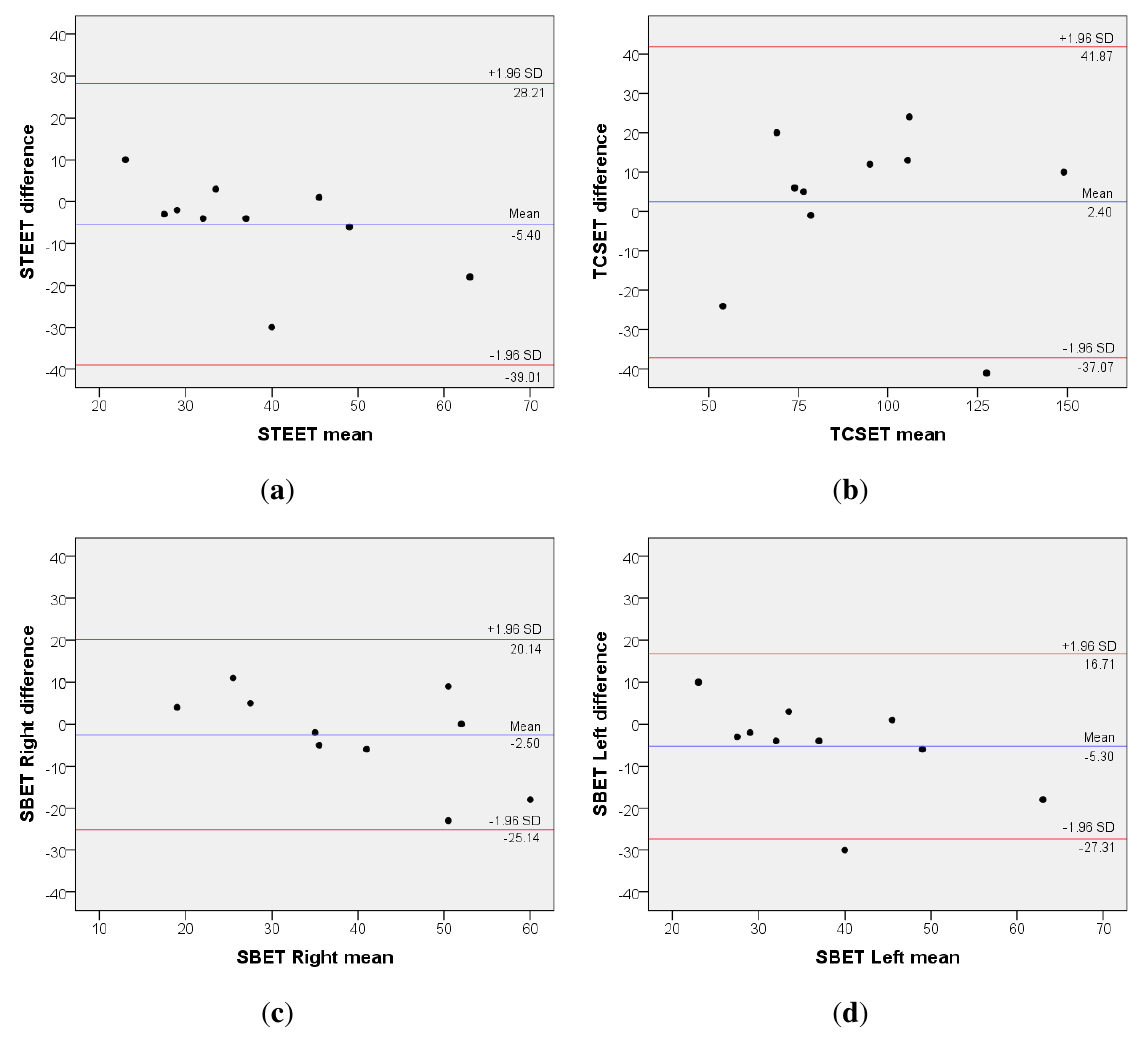
Figure 6. Agreement analysis between traditional trunk endurance assessment and mDurance through Bland–Altman plots: ( a ) STEET; ( b ) TCSET; ( c ) SBET right; and ( d ) SBET left. The mean of differences ( ¯ x ) is represented by a blue line, while the limits of agreement ( ¯ x ± 1 . 96 σ ) are depicted in X